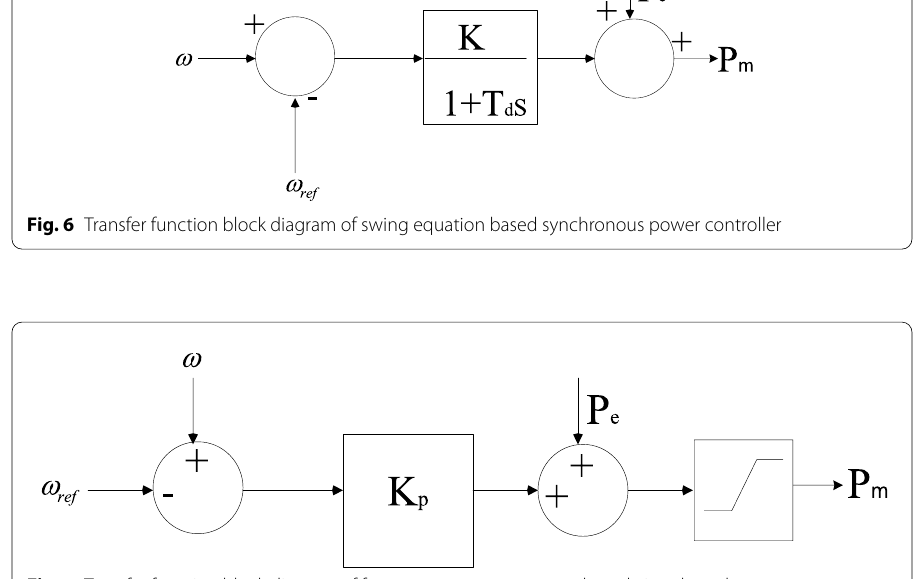
Fig. 7 Transfer function block diagram of frequency-power response-based virtual synchronous generator